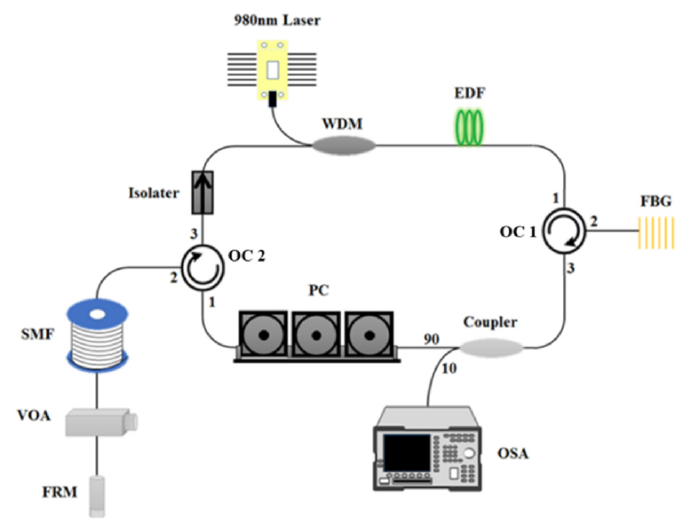
Figure 1. The structure of the experimental setup. WDM: wavelength division multiplexing device; EDF: Erbium-doped fiber; FBG: fiber Bragg grating; OC 1, OC 2: optical circulator; PC: polarization controller; SMF: single-mode fiber; VOA: variable optical attenuator; FRM: Faraday rotating mirror;